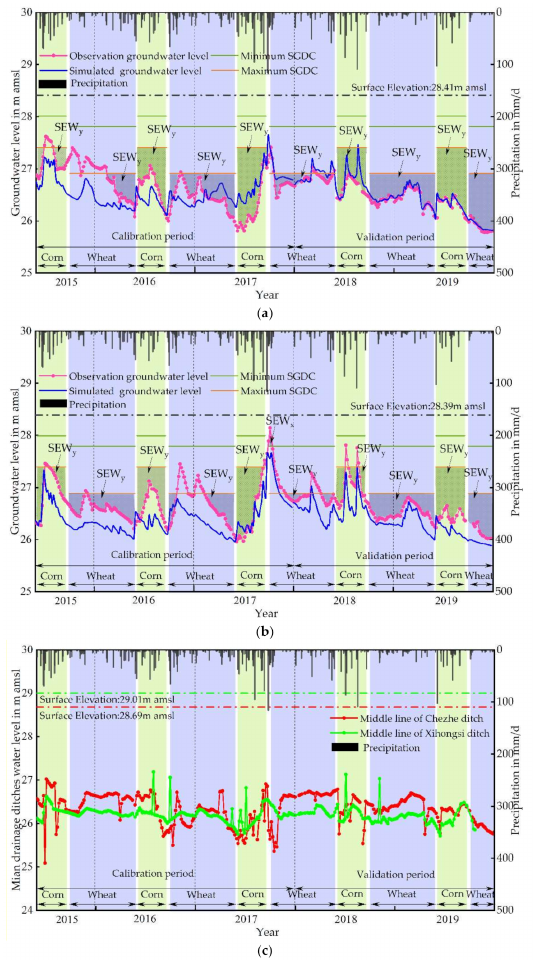
Figure 4. ( a ) Simulated and measured groundwater-level-change process of the representative field around M2 near the ditch ( b ) and the representative field around M5 far from the ditch, from 2015 to 2019; ( c ) water-level-change process of the Chezhe ditch and Xihongsi ditch in the middle line, where ditches cross the groundwater observation well line in the middle section (see Figure